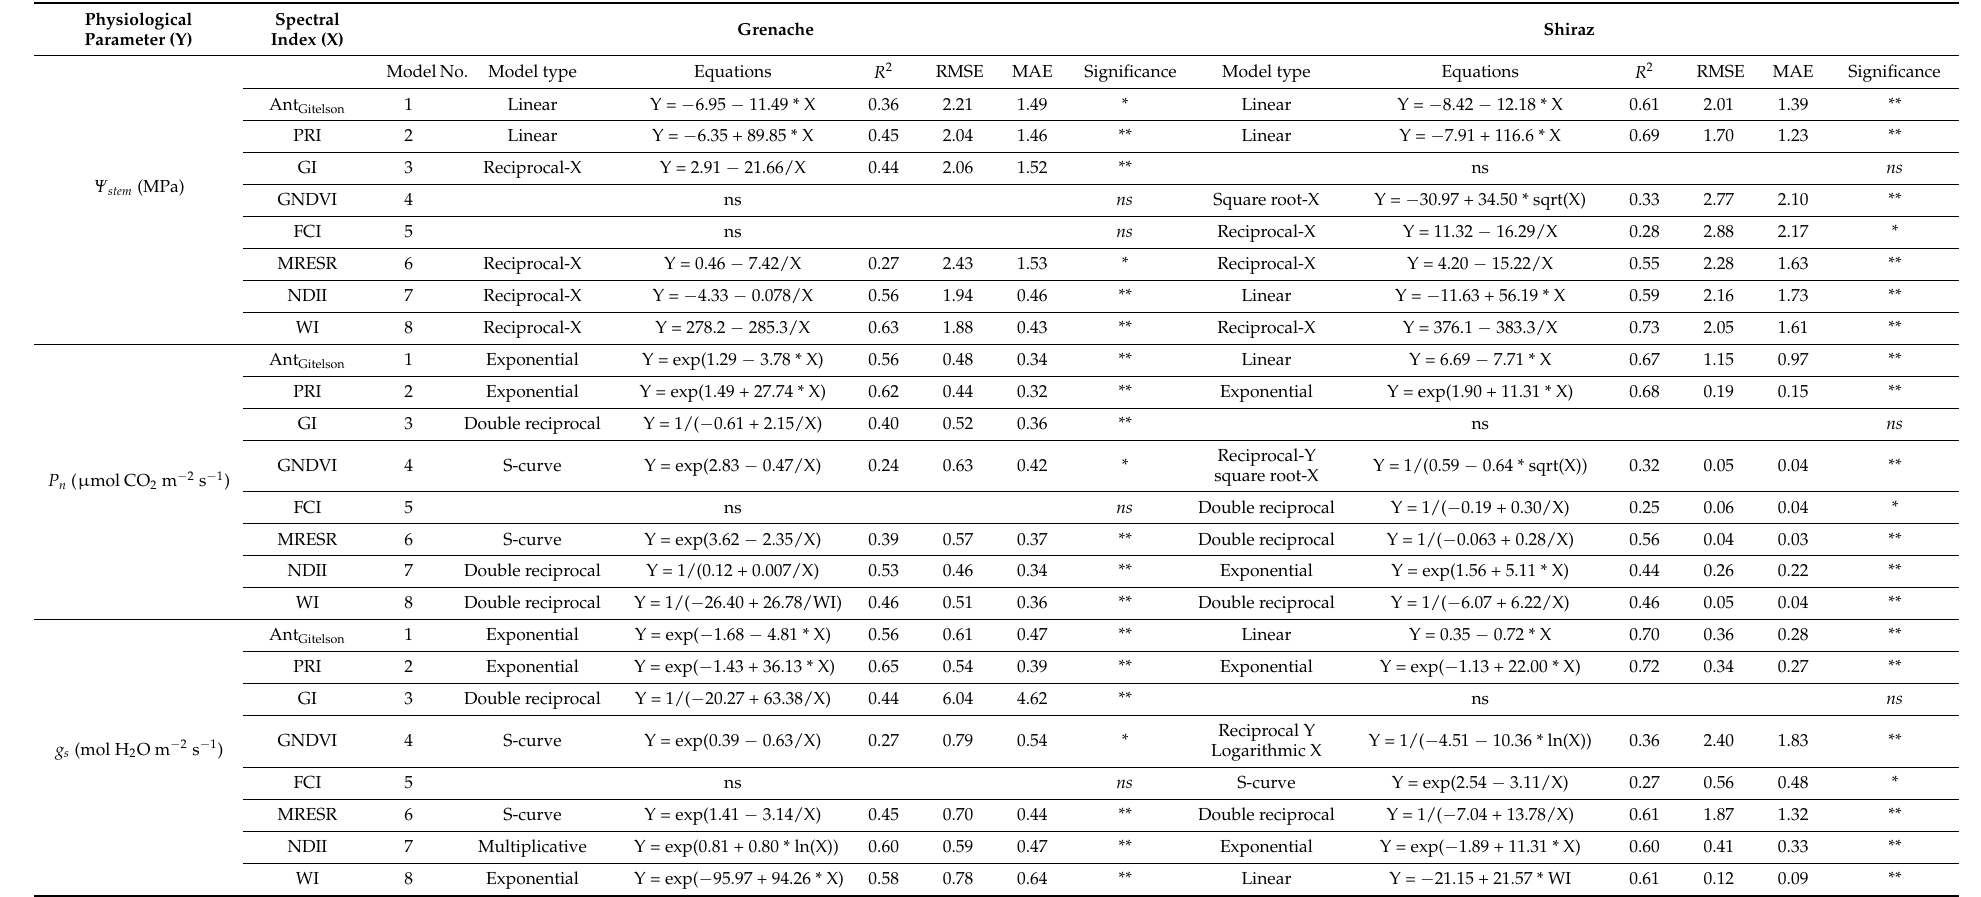
Table 4. Relationship between physiological parameters and acquired hyperspectral indices for Grenache and Shiraz grapevines. For each physiological parameter, the best regression model in terms of R 2 is shown in bold. Single asterisk indicates a significant correlation, p < 0.05; double asterisk indicates a significant correlation, p < 0.01, ns indicates a not-significant correlation ( p >